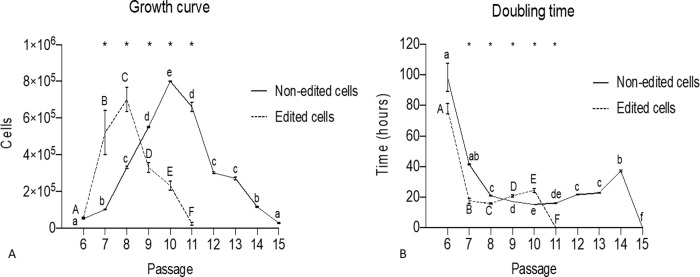
Growth curve and cell doubling time for non–edited and edited cells.a-f Different lowercase letters indicate significant differences between non-edited cells (p<0.05). A-F Different lowercase letters indicate significant differences between non-gene-edited cells (p<0.05). * Significant differences between edition within passage (p<0.05).